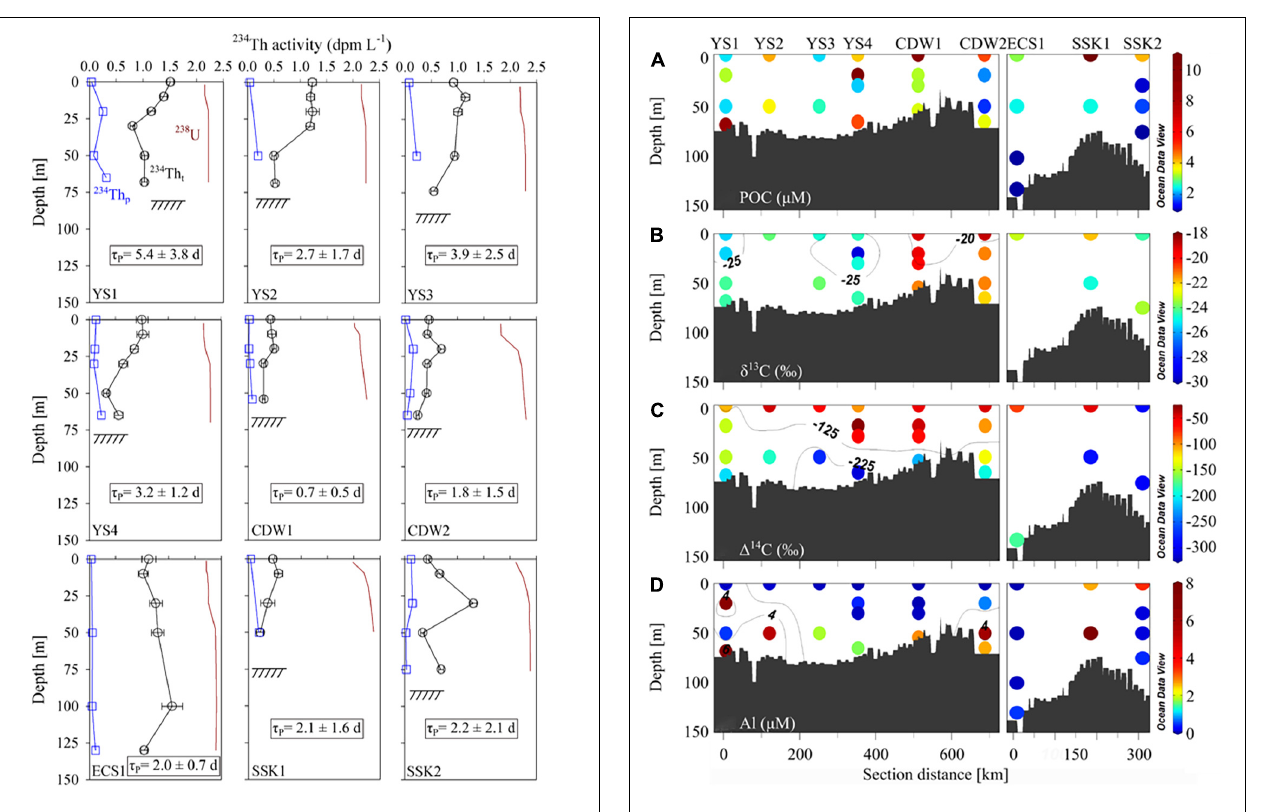
FIGURE 4 | Distributions of (A) POC concentration, (B) δ 13 C, (C) (cid:49) 14 C, and (D) particulate Al concentration, along the transect shown in Figure 1